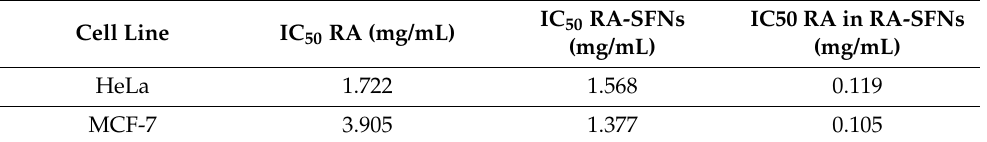
Table 3. IC 50 values for RA, RA-SFNs and RA contained in RA-SFNs (calculated from DLC value) against HeLa and MCF-7 cell lines as determined by MTT assay. Values were calculated by GraphPad Prism V8.